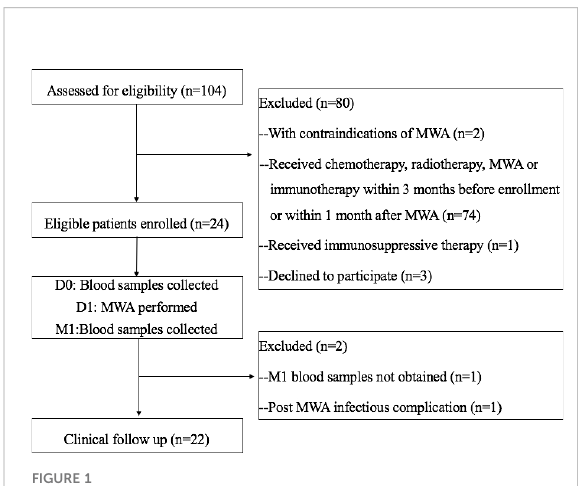
FIGURE 1 Flowchart of the study. D0, day before MWA; D1, day of MWA; M1, one month after MWA; MWA, percutaneous microwave